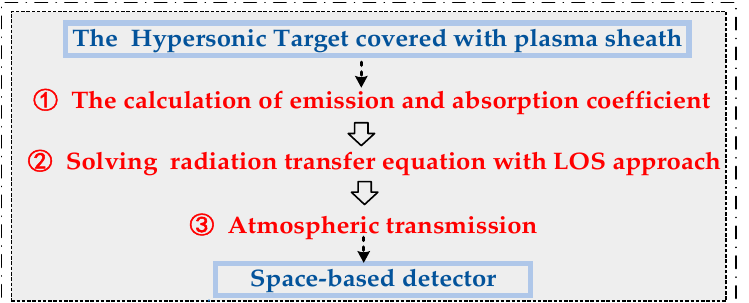
Figure 1. The flow chart for calculating spectral radiation characteristics for HTs.